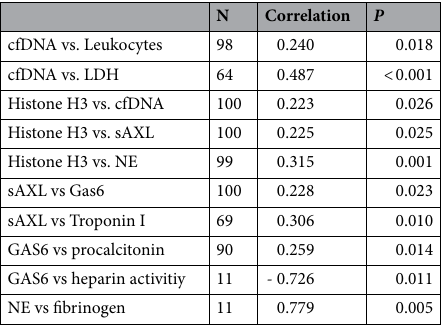
Table 2. Correlations between various parameters measured at day 1. Correlations were calculated with the Spearman’s rank-order correlation test, only significant correlations are mentioned here. LDH Lactate dehydrogenase.